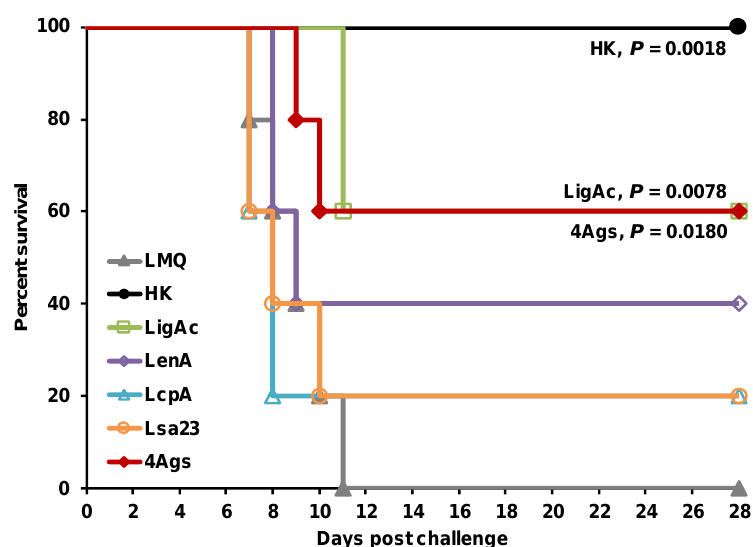
Figure 4. Kaplan–Meier plot showing protection of vaccinated hamsters against challenge by live Leptospira . The hamsters were immunized with the various vaccine formulations shown in Table S3. Each vaccinated hamster was challenged intraperitoneally by 20 × LD 50 of low passage leptospires. Their survival was monitored daily until the end point of 28 days. The percentage of hamster survival was calculated as the number of survivors divided by the total number of animals challenged. Statistical values of survival rate between adjuvant control group and other vaccination groups were analyzed by log-rank test. Vaccination was with LMQ = phosphate bu ff ered saline and LMQ (a combination of neutral liposome, monophosphoryl lipid A, and Quillaja saponaria fraction 21); HK = Heat-killed whole cell vaccine; LigAc, LenA, LcpA or Lsa23 = LigAc, LenA, LcpA, or Lsa23 mono recombinant factor Lsa23) and LMQ. Table 1. Protection conferred by immunization with vaccines in hamsters.